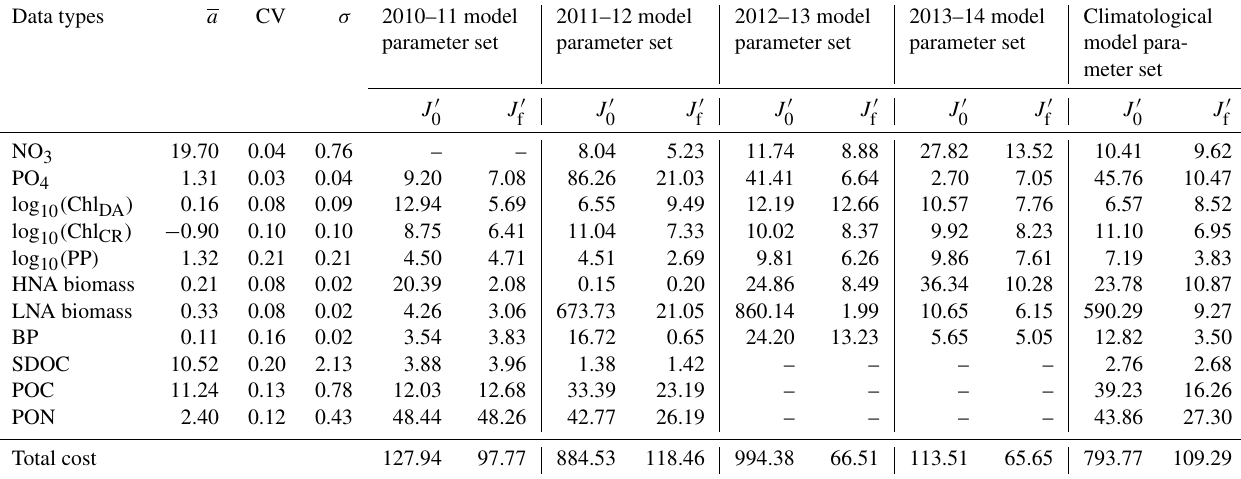
Table 2. Data types, observed means, coefficient of variation, target errors, and costs before and after optimization. The observed mean ( a ), coefficient of variation (CV), and target error ( σ ) of each assimilated data type used for calculating the normalized cost function (unitless; Eq. 3) before ( J (cid:48) ) and after optimization ( J (cid:48) ). Data type unit: mmolNm − 3 for nitrate (NO 3 ); mmolPm − 3 phosphate (PO 4 ); mgm − 3 for 0 f diatom chlorophyll (Chl DA ) and cryptophyte chlorophyll (Chl CR ); mmolCm − 3 for HNA and LNA bacterial biomass, SDOC, and POC; mmolNm − 3 for PON; and mmolCm − 3 d − 1 for primary production (PP) and bacterial production (BP). NO 3 was not assimilated in 2010–